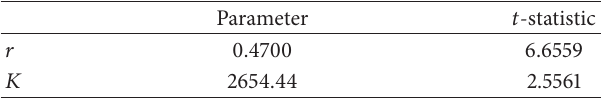
Table1:Resultsfromfittingstockdatatoalogisticmodelwithlinear